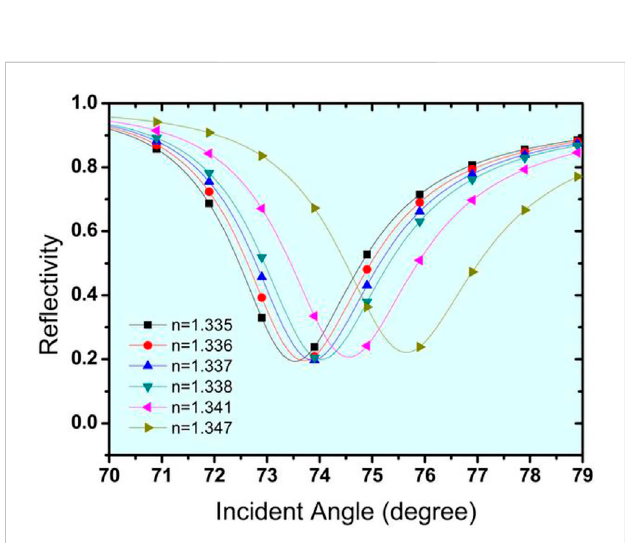
FIGURE 7 Re fl ectivity curve with respect to change in incident angle for the detection of urine glucose in bio-sample for Structure-II (Prism/Au/Si/ BP/Bio-sample) with effect of BP